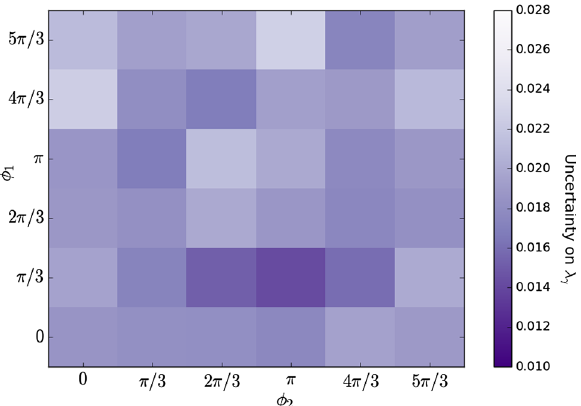
Fig. 5 Uncertainty on λ γ obtained from amplitude fits of simulated samples of B 0 → K 1 ( 1270 ) 0 γ decays, shown as a function of the phasedifferencesofthe K 1 ( 1270 ) 0 → K + ρ( 770 ) − and K 1 ( 1270 ) 0 → K ∗ ( 892 ) 0 π 0 decay modes relative to the K 1 ( 1270 ) 0 → K ∗ ( 892 ) + π − decay mode, denoted as φ 1 and φ 2 respectively. Each bin contains the average uncertainty of 10 amplitude fits performed on samples gener- ated with the same model